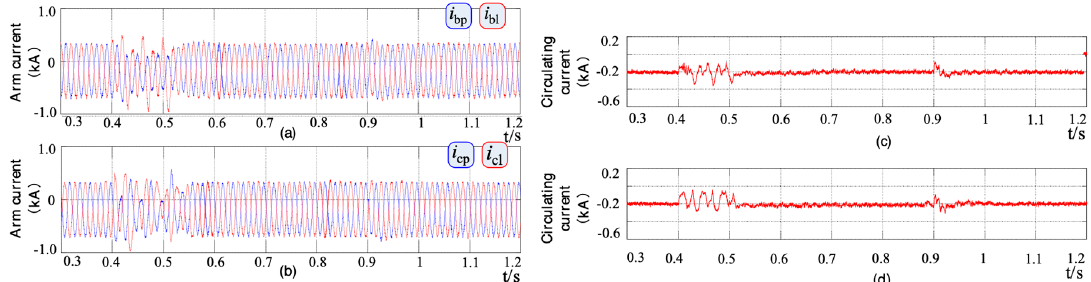
Figure 1. Simulation results of fault condition 2: ( a ) Arm current of phase b; ( b ) Arm current of phase c; ( c ) Circulating current of phase b; ( d ) Circulating current of phase c.